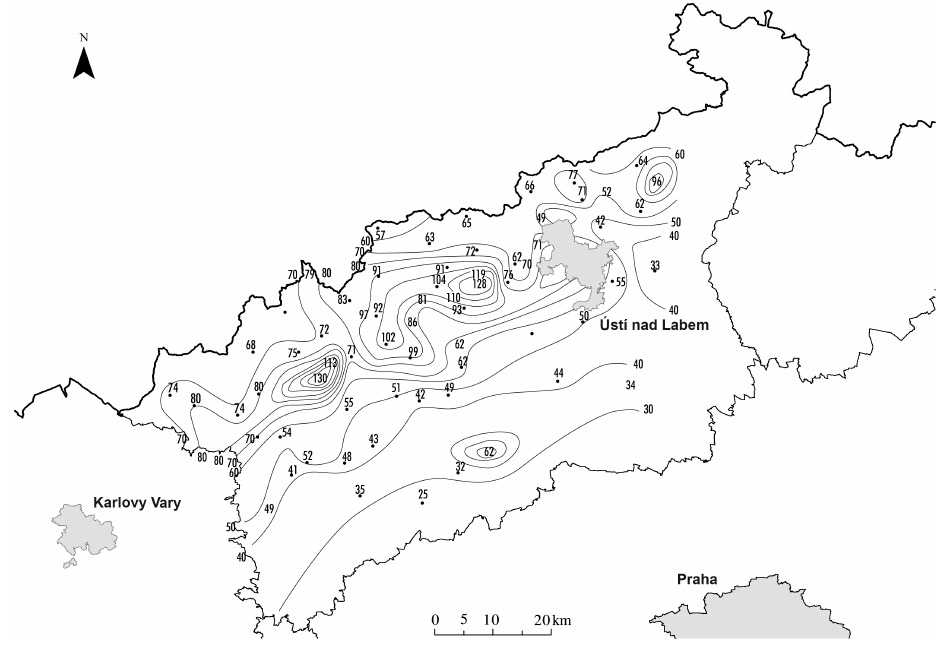
Figure 3. Map of Northwest Bohemia (NWR in Figure 2), showing the SO 2 annual means in µg m − 3 in 1971 – 1980, the lines represent the isoconcentrations (redrawn according to [20]).